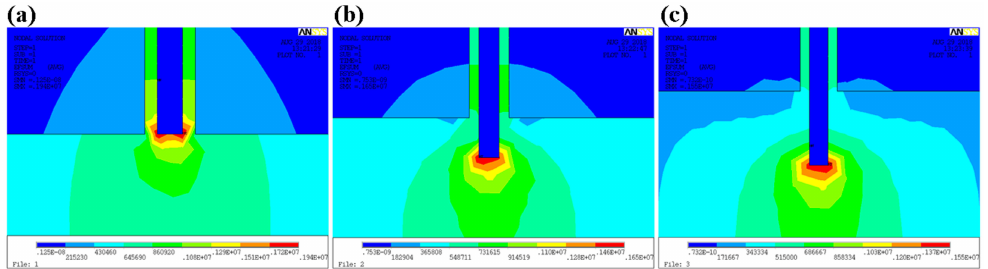
Figure 2. Flow field simulation for different spinneret designs. ( a ) Schematic diagram for the airflow-assisted spinneret; ( b ) flow field simulation when L = 0 mm; ( c ) flow field simulation when L = 1 mm; ( d ) flow field simulation when L = 2 mm; ( e ) distribution of airflow velocity for different spinneret designs.